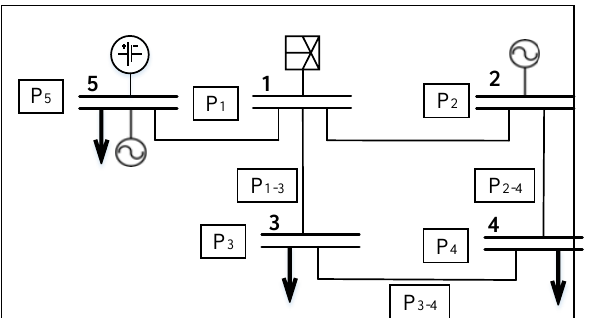
Fig.8. Reference values of SOC